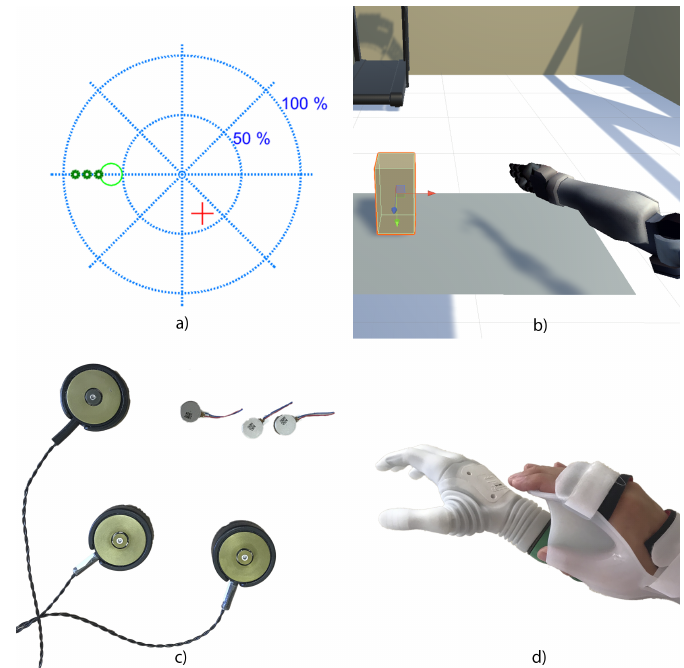
Figure 3. Common used feedbacks. ( a ) Visual interface representing the model estimation output as a red cross and the target as a green circle; ( b ) Virtual Reality environment to perform upper limb prosthesis control tasks; ( c ) Vibrotactors used to provide sensory-motor feedback to the user; ( d ) An actual prosthesis with two degrees of freedom and changeable grasp type used by an able-bodied